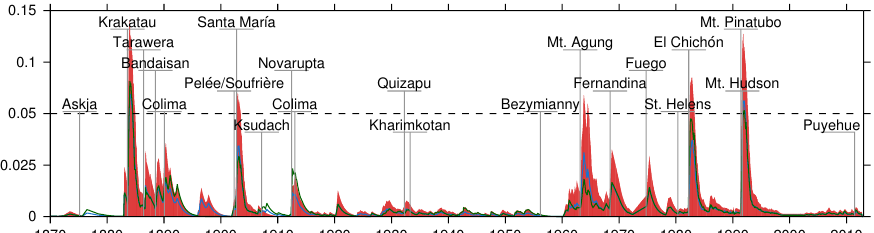
Figure 2. Tropical averaged stratospheric aerosol optical depth (AOD) at 550nm for the altitude region 20–25km from Sato et al. (1993); the updated dataset is from http://data.giss.nasa.gov/modelforce/strataer/. All volcanic eruptions from Fig. 1 for the period 1870 until present are included. They are indicated with a grey line corresponding to the eruption time and the name of the volcano. The green line is the mean AOD for the Northern Hemisphere and the blue line shows the mean AOD for the Southern